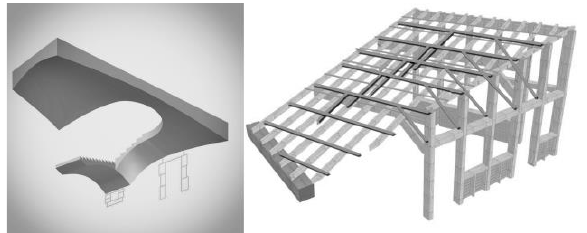
Figure 8. Using traditional techniques should not be a limitation in contemporary architectural language